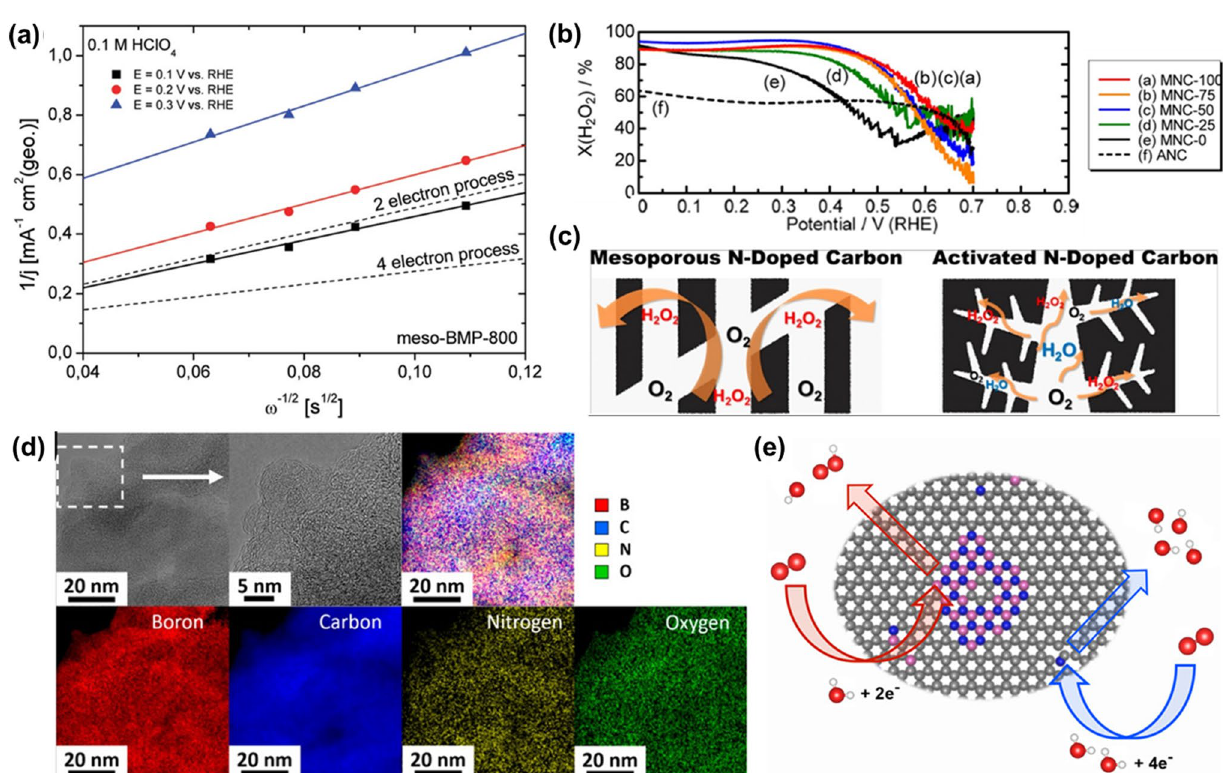
Fig. 16 a The number of electrons transferred based on the Koutecky–Levich plot. Reproduced with permission from Ref. [236]. Copyright 2012 American Chemical Society. b RRDE voltammograms toward ORR over the MNCs and ANC. c Schematic illustration of the ORR on dif- ferent N-doped carbon. Reproduced with permission from Ref. [237]. Copyright 2014 American Chemical Society. d HRTEM and elemental mapping images of BN-C1. e Schematic illustration of the types of doping motifs and ORR mechanisms on these active sites in the B,N co- doped electrocatalysts (C: gray, N: blue, B: red; O: white). Reproduced with permission from Ref. [241]. Copyright 2018 American Chemical